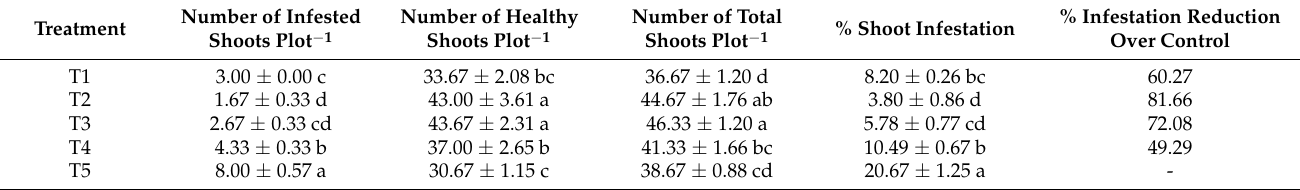
Values within a column are means of three replications for each treatment ± standard errors. Means within the same letter(s) within a column do not differ significantly ( p ≤ 0.05) according to Duncan’s multiple range tests(DMRT). T1: Bacillus thuringiensis (Bt), T2: Spinosad 45 SC, T3: Abamectin 1.8 EC, T4: Azadirachtin 1% EC, and T5: Untreated